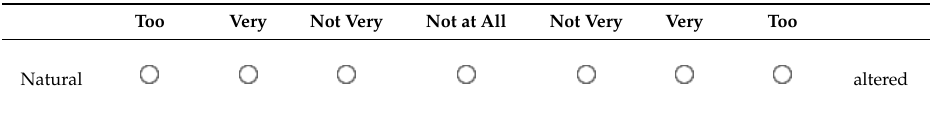
Figure A2. Google Earth aerial images used: ( A ) Freire, ( B ) Lumaco, ( C ) Pucón, ( D ) Curarrehue. (Scale of 1:10,000).